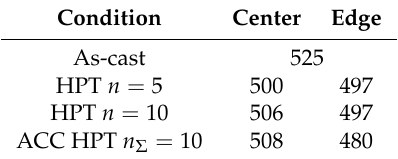
Table 3. Microhardness of the Vit105 samples, processed by HPT via different